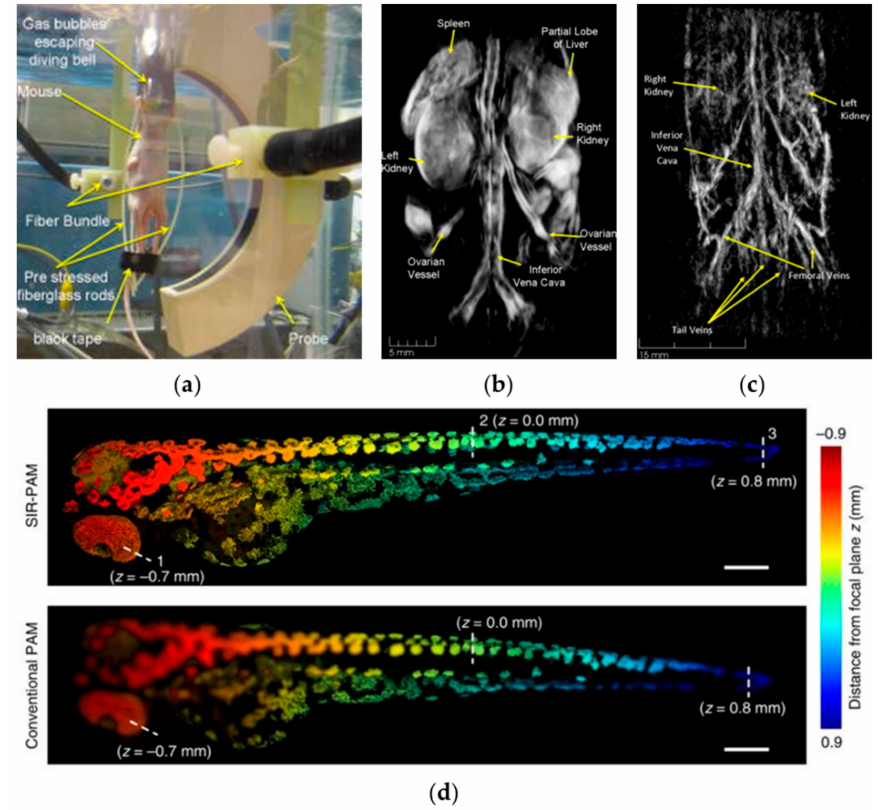
Figure 3. ( a ) Photograph of the whole-body PA imaging of a nude mouse; ( b ) whole-body PA imaging of a nude mouse with 755 nm excitation; ( c ) whole-body PA imaging of a nude mouse with 1064 nm excitation; ( d ) whole-body PA images of zebrafish embryos encoded with imaging depth. Reprinted with permission from